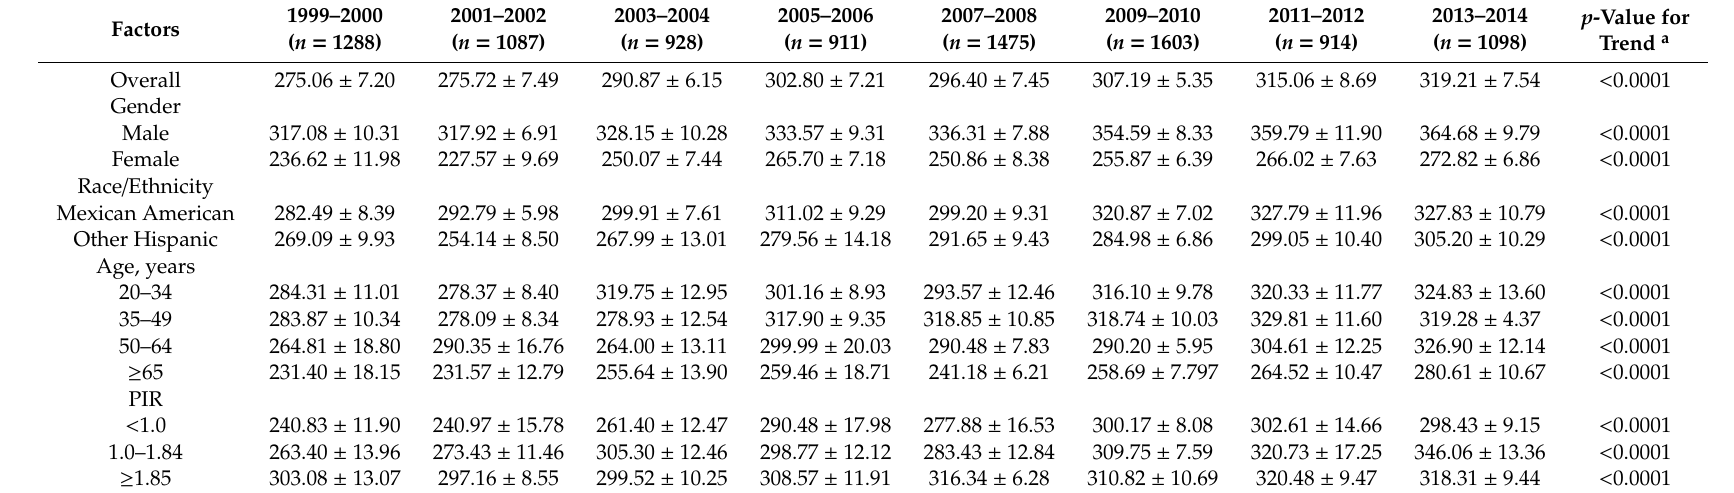
Table 2. Trends in daily dietary magnesium intake (mg / day) among Hispanic adults aged ≥ 20 years, the National Health and Nutrition Examination Survey (NHANES) 1999–2014* ( n =